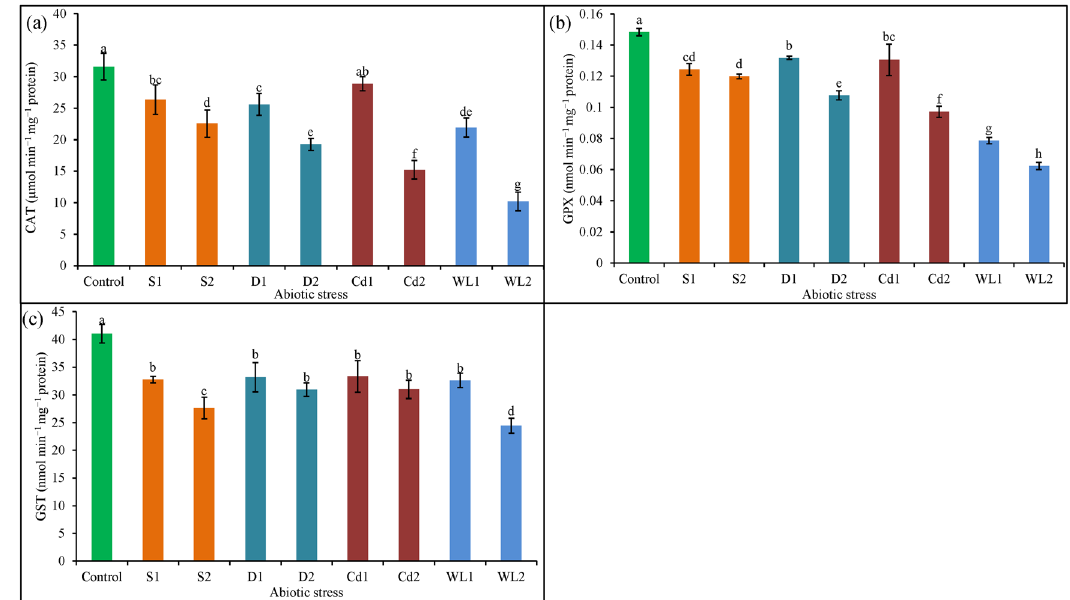
Figure 7: CAT ( a ) , GPX ( b ) , and GST ( c ) activities of C. olitorius plants a ff ected by di ff erent abiotic stresses. S 1 , S 2 , D 1 , D 2 , Cd 1 , Cd 2 , WL 1 , and WL 2 represent 200 mM of NaCl, 400 mM of NaCl, 10 days of water de fi cit, 15 days of water de fi cit, 2 mM of CdCl 2 , 4 mM of CdCl 2 , 5 days of waterlogging, and 15 days of waterlogging, respectively. Mean value (± SD ) was calculated from three replicates for each treatment. Values in a column with di ff erent letters are signi fi cantly di ff erent at p ≤ 0.05 applying LSD